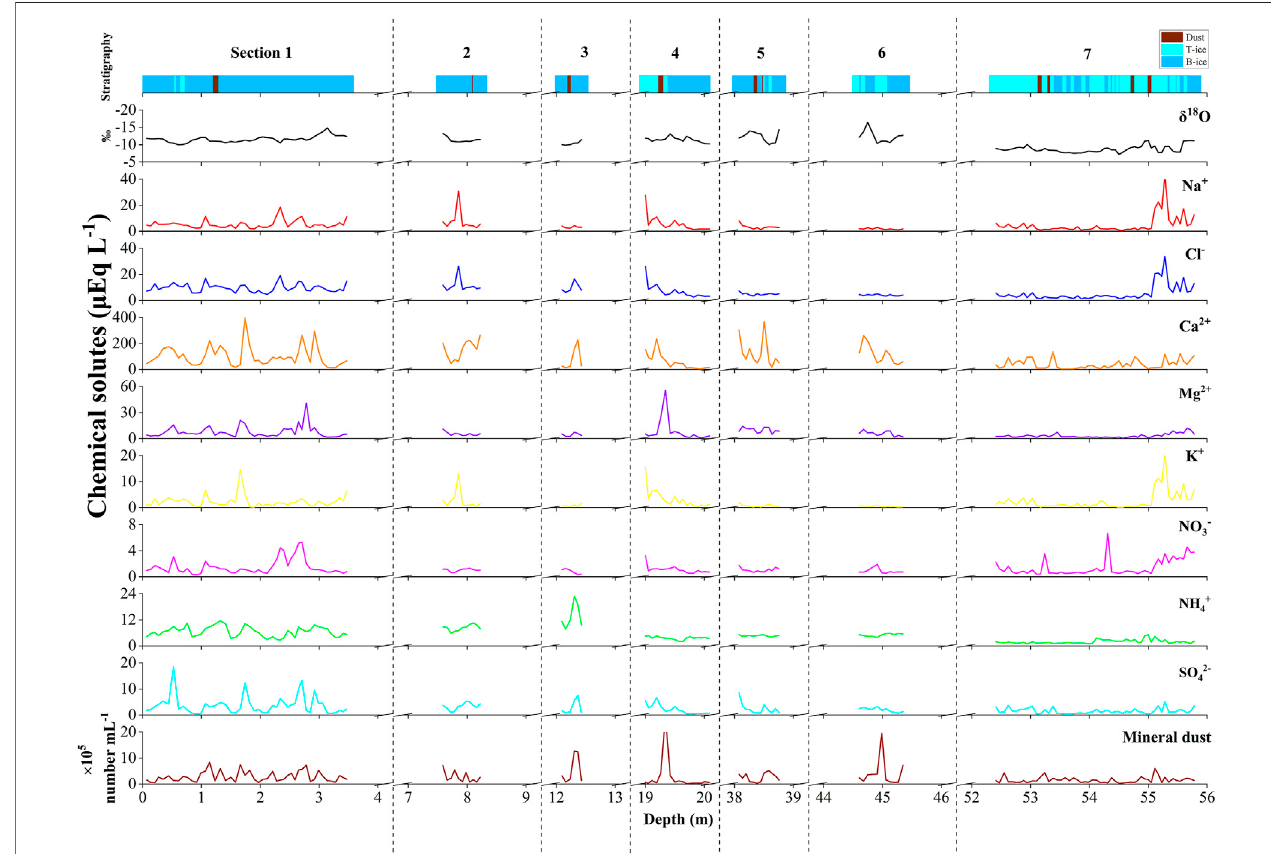
FIGURE 2 | Pro fi les of stratigraphy, oxygen stable isotope, concentrations of major chemical solutes and mineral dust in the seven sections of Core A drilled from the ablation area of the glacier. T-ice represents transparent ice; B-ice represents bubble ice.